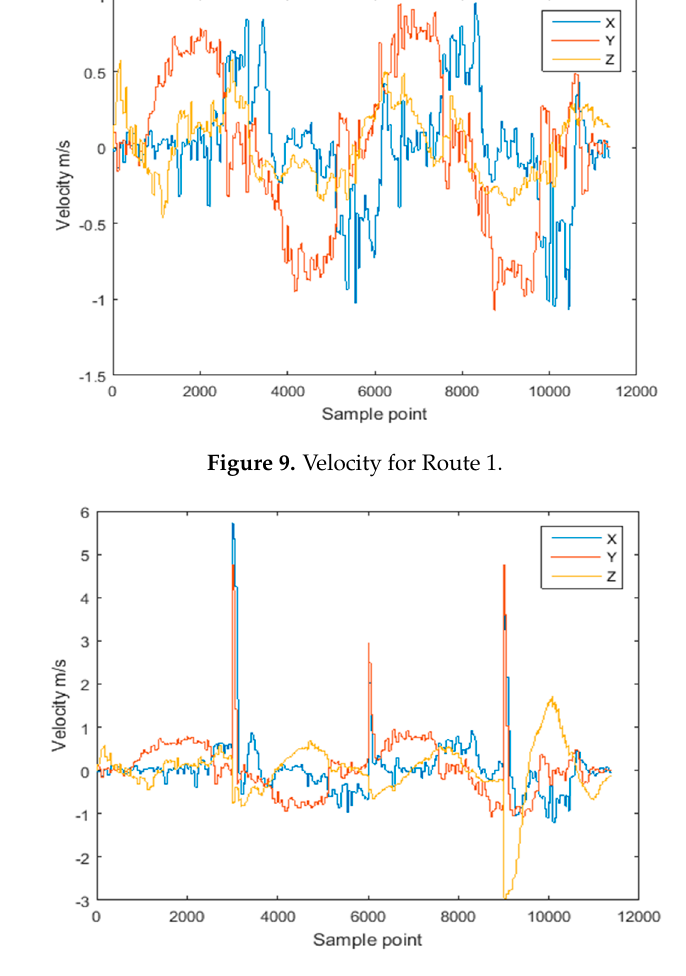
Figure 10. Velocity of inserting three noise for Route 1.